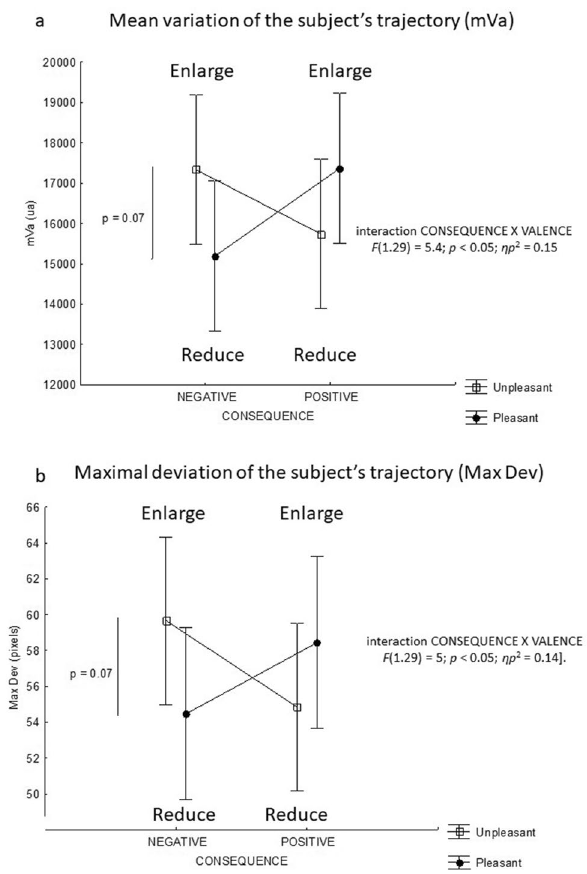
Figure 3. Spatial parameters . (a) Mean absolute angular error of the trajectory at the end of the initial impulse. A negative consequence for a pleasant or unpleasant picture corresponds to a reduction or an enlargement, respectively. A positive consequence for a pleasant or unpleasant picture corresponds to an enlargement or a reduction, respectively. p = 0.061 indicates a tendency towards an interaction between consequence and valence. (b) Mean absolute lateral gap between the stylus and the centre of the target at the end of the movement. *p <